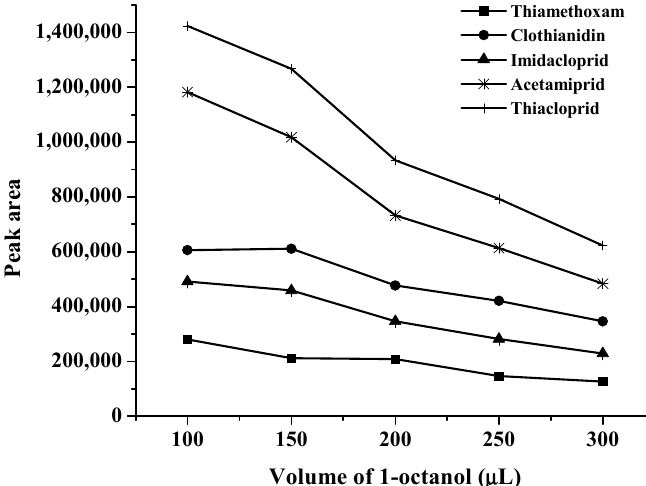
Figure 4. E ff ect of volume of 1-octanol on the extraction of studied neonicotinoids. Figure 4. Effect of volume of 1-octanol on the extraction of studied neonicotinoids.